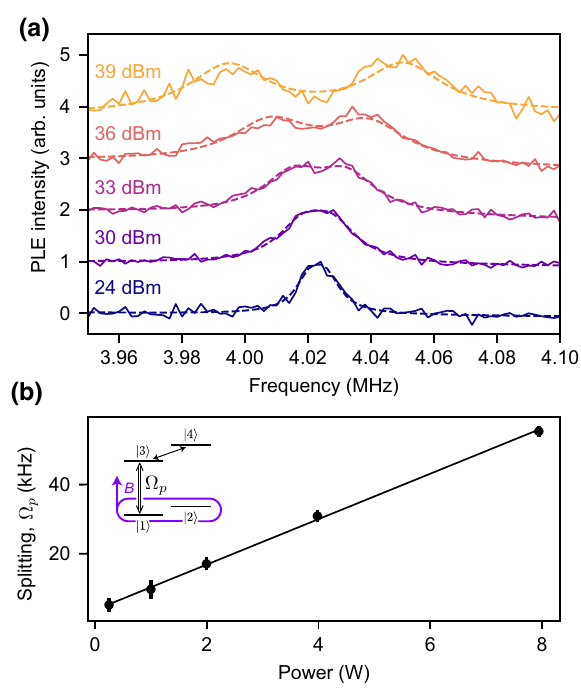
FIG. 5. Autler-Townes splitting of the MW ⇑ transition as a function of MW ⇑ power. (a) Spectra recorded by our scanning the nuclear flip transition with a non-phase-coherent rf source. The ODMR PL signal is generated by excitation to the TX 0 state by a laser resonant with the B 1 optical transition [scheme shown in the inset in (b)]. As the MW ⇑ power (text labels) increases, AT splitting becomes clear. Dashed lines are a split-peak fit to each dataset. (b) Splitting from fits (equal to the MW ⇑ Rabi frequency (cid:9) p ) as a function of resonant